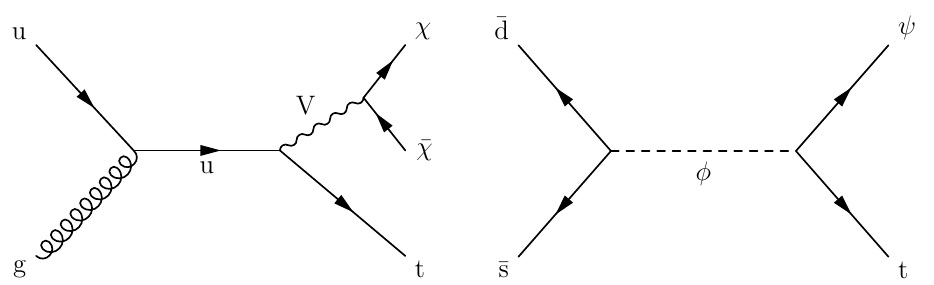
Figure 1 . Example Feynman diagrams of monotop production via a (cid:13)avor-changing neutral current V (left) and a charged, heavy scalar resonance (cid:30)